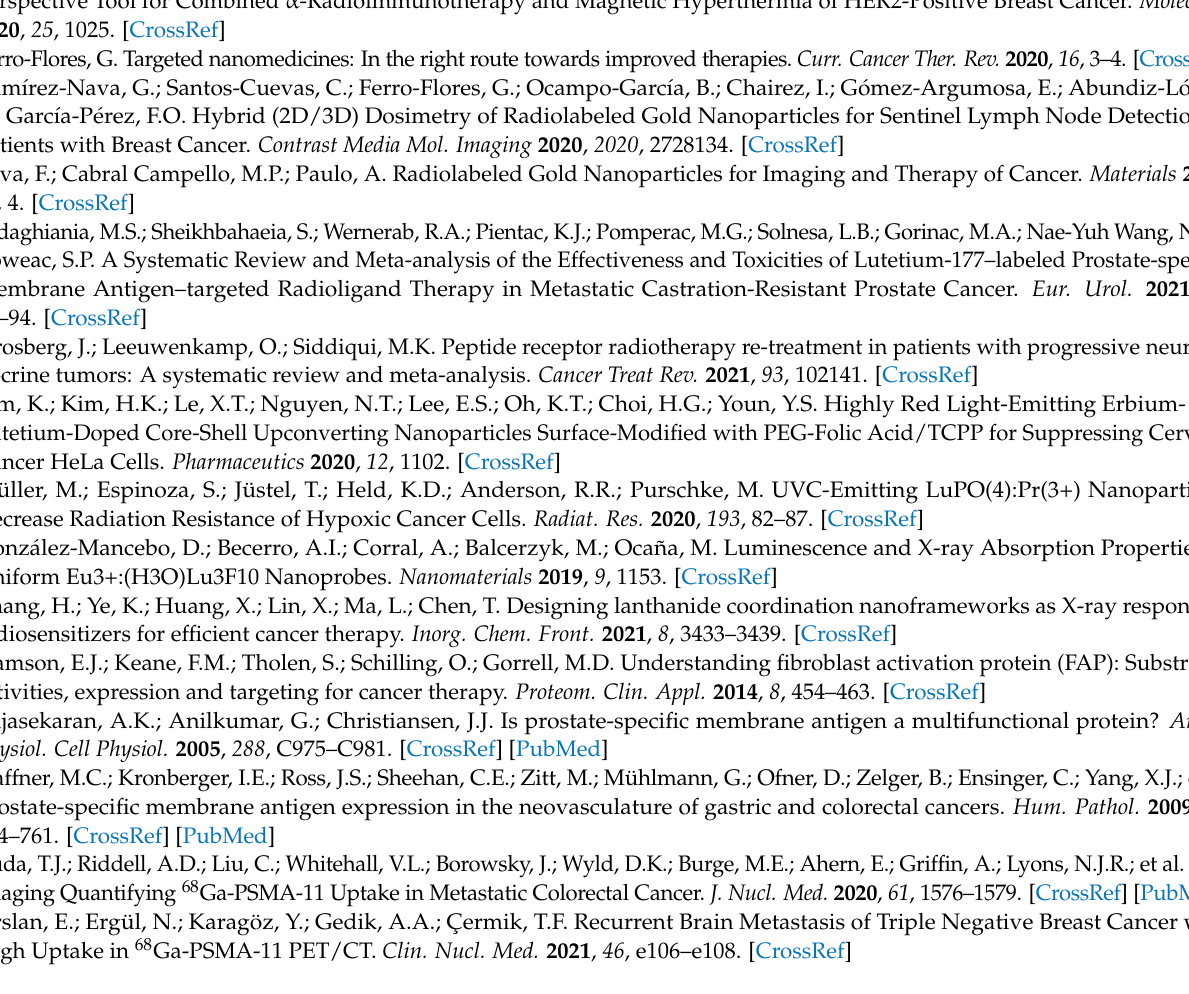
Figure A2. ( a ) Anterior and posterior whole-body planar gamma images of a patient with colorectal liver metastases 1 h after intravenous administration of 177 Lu 2 O 3 -iPSMA nanoparticles (185 MBq), ( b ) Abdominal SPECT imaging of a patient with multiple colorectal liver metastases 1 h after intravenous administration of 177 Lu 2 O 3 -iPSMA nanoparticles (185 MBq), ( c ) Abdominal SPECT/CT imaging of a patient with multiple colorectal liver metastases 1 h after intravenous administration of 177 Lu 2 O 3 -iPSMA nanoparticles (185 MBq).